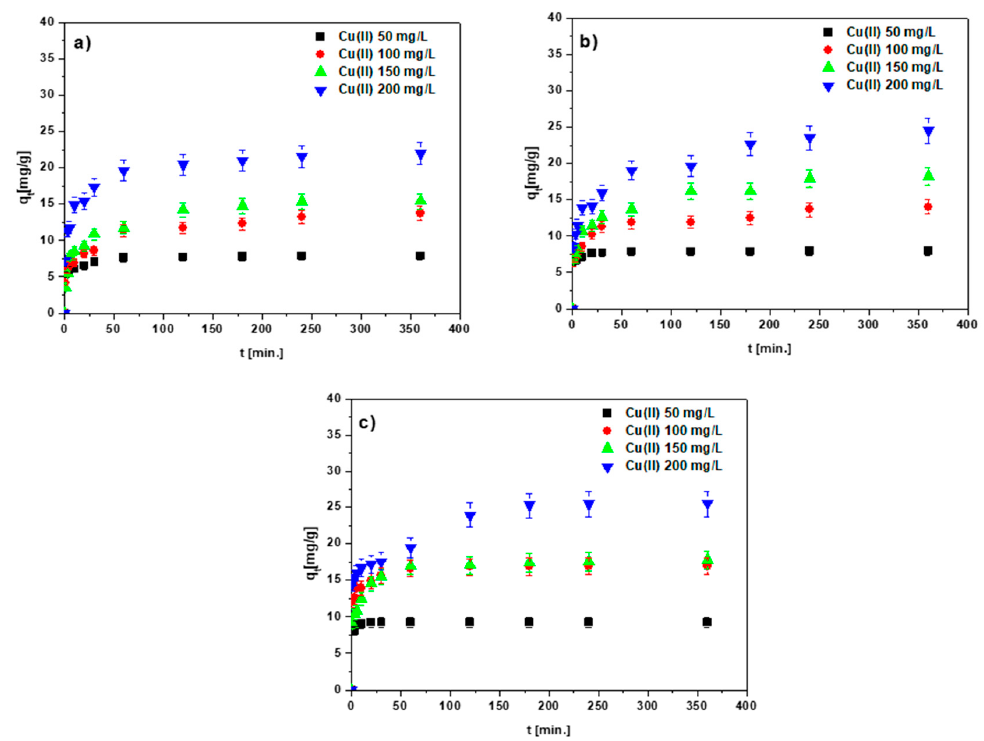
Figure 11. Effect of the phase contact time on the Cu(II) adsorption on ( a ) BC-CS 1-1, ( b ) BC-CS 2-1 and ( c ) BC-CS 4-1 (pH 5, sorbent mass 0.1 g, shaking speed 180 rpm, temperature 293 K). The number of adsorbed ions increased with the increasing contact time of the sorbent-solution phases and the concentration of the initial solution. The Cu(II) ion equi- librium capacities were found to be 7.87, 13.74, 15.40 and 21.95 mg/g for BC-CS 1-1; 7.95, 14.01, 18.22 and 24.53 mg/g for BC-CS 2-; and 9.18, 16.90, 17.79 and 25.51 mg/g for BC-CS 4-1, at the concentrations 50, 100, 150 and 200 mg/L, respectively. The largest number of adsorbed ions was found for BC-CS 4-1. The other values of q e for the other heavy metal ions are listed in Tables 3, S1 and S2. The largest values of adsorbed Cd(II), Zn(II), Co(II)